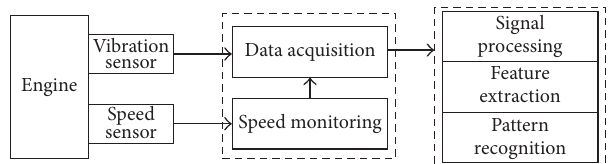
Figure 1: The framework of measurement